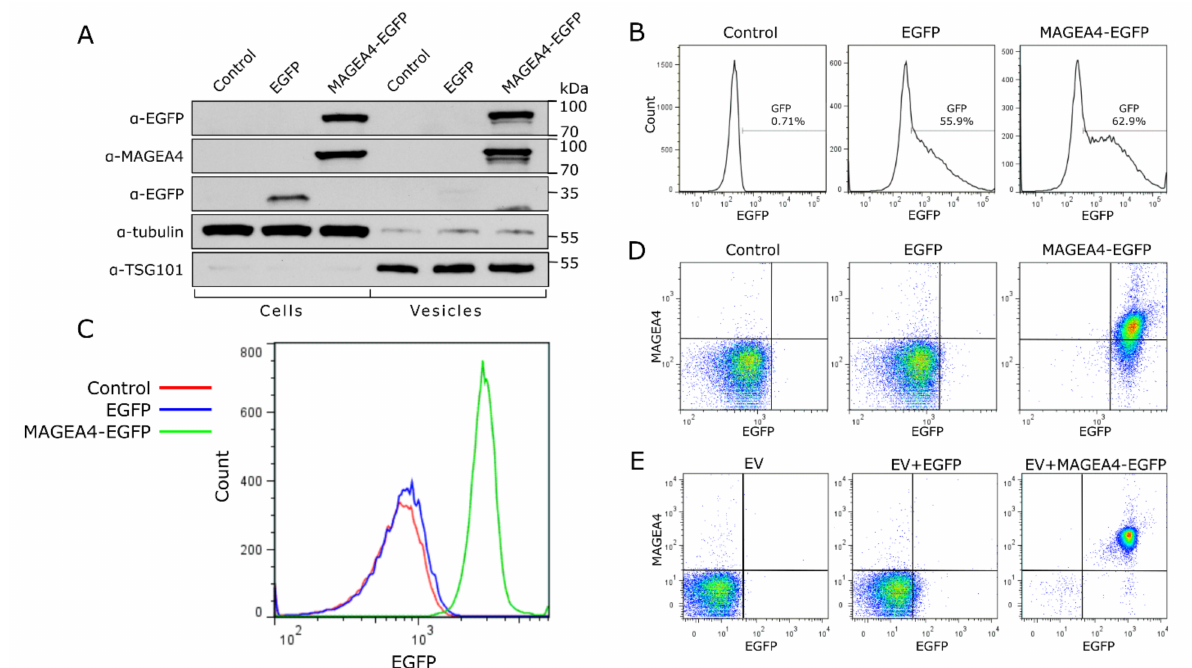
Figure 5. MAGEA4 is able to load the marker protein EGFP onto EVs. ( A ) Western blot analysis of cells transfected with expression plasmid for MAGEA4-EGFP and EGFP proteins and EVs isolated from the cell culture media of transfected cells. Control—mock cells transfected with empty vector. ( B ) The transfection efficiency of cells transfected with expression plasmid for MAGEA4-EGFP and EGFP. ( C ) The EGFP fluorescence profile of EVs isolated from the cell culture media of transfected cells. Control—mock cells transfected with empty vector. ( D ) The dot blot of EVs isolated from the cell culture media of transfected cells. EV-bound latex beads were incubated with anti-MAGEA4 and Alexa 568-conjugated secondary antibodies. ( E ) Dot blot analysis of in vitro binding experiment. EVs from non-transfected cells were incubated with purified EGFP or MAGEA4-EGFP protein or with no protein as control and purified through ultracentrifugation. Signals of EV-bound latex beads obtained with anti-MAGEA4 and Alexa 568-conjugated secondary antibody (for MAGEA4) and the fluorescence of EGFP are